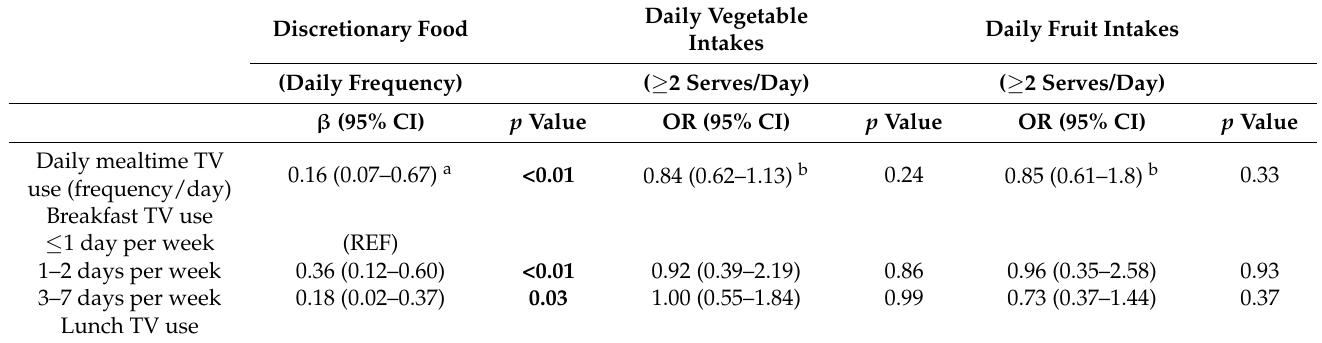
Table 3. Adjusted models. Association between children’s mealtime TV use at baseline and con- suming two or more serves of fruit and vegetables per day, and consuming non-core discretionary foods on more than one occasion per day at the follow-up, adjusting for baseline intakes and covari- ates